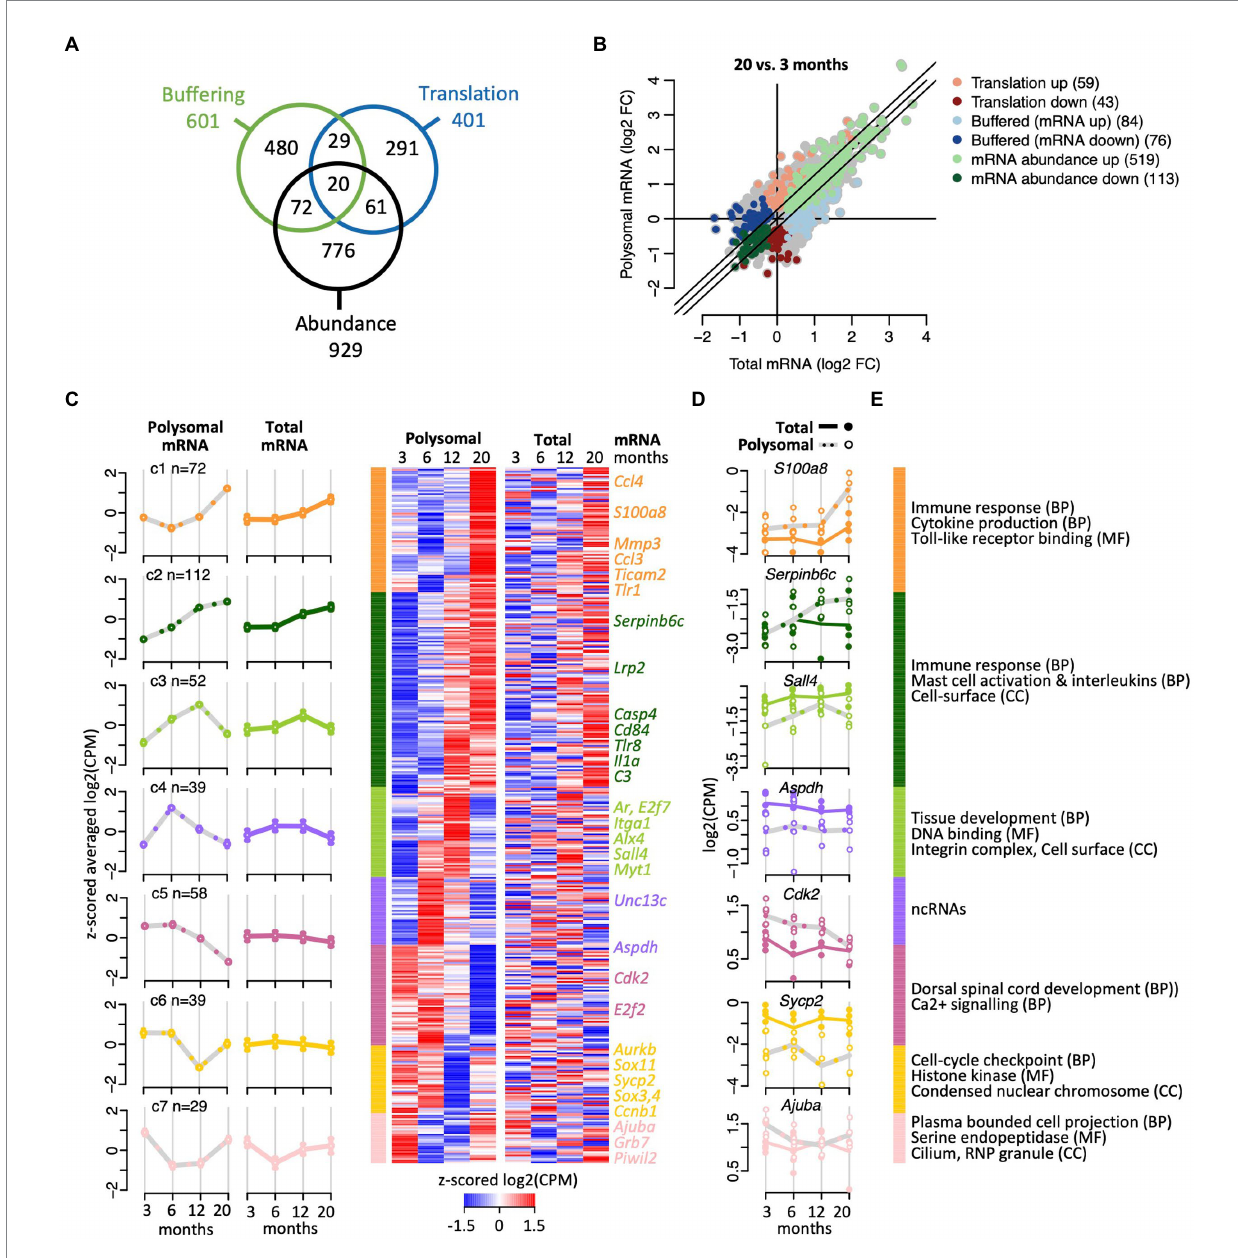
FIGURE 3 Translational efficiency analysis identifying age-related changes of mRNA expression. (A) Venn diagram shows overlap of numbers of transcripts identified with anota2seq across the indicated three regulatory modes. (B) Fold-changes (FC) in total mRNA ( x -axis) and polysomal mRNA levels ( y- axis) of 20-month-old vs. 6-month-old mice. Colors depict genes allocated to the three regulatory modes. Number of genes is indicated within brackets. (C) Cluster heatmap and averaged temporal profiles of genes displaying alteration in the ‘translation’ regulatory mode during aging ( n = 401 genes). Clustering was based on the polysomal RNA (translatome) profiles; corresponding total RNA (transcriptome) data is displayed to the right. Average profiles for each cluster are shown to the left with a continuous line for total RNA, a gray dashed line for polysomal RNA, and error